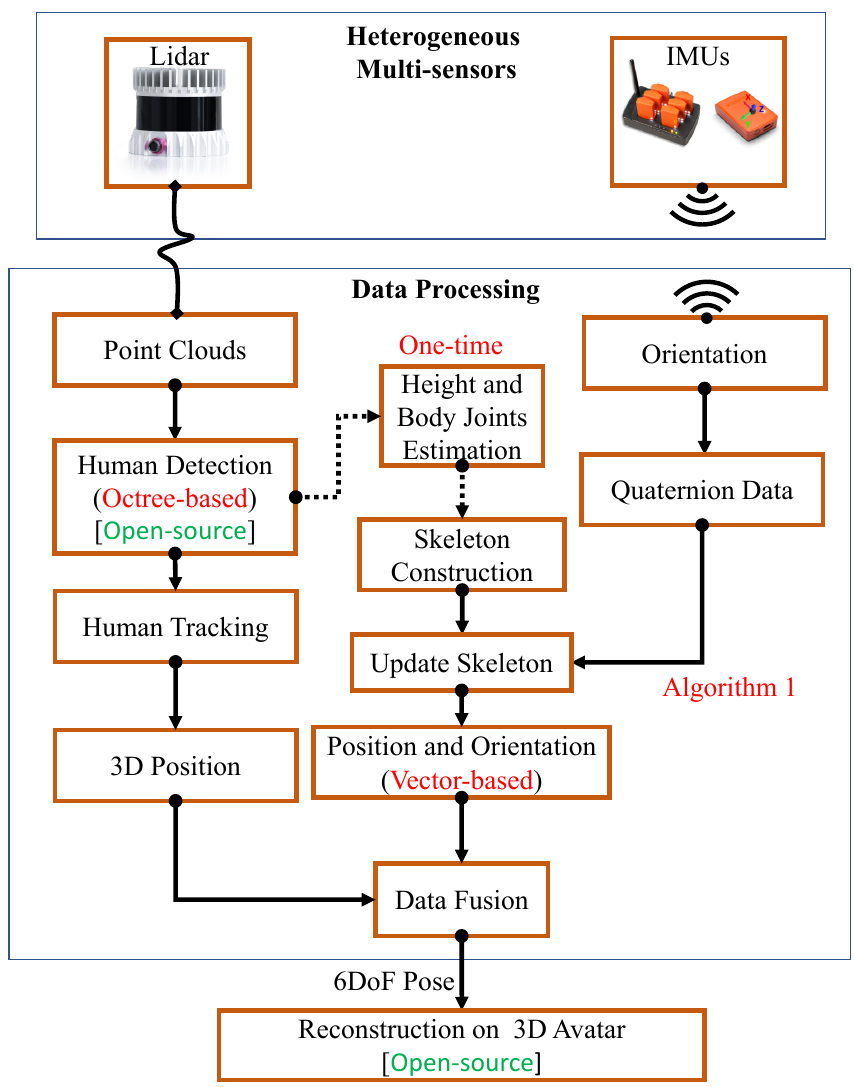
Figure 1. Proposed system